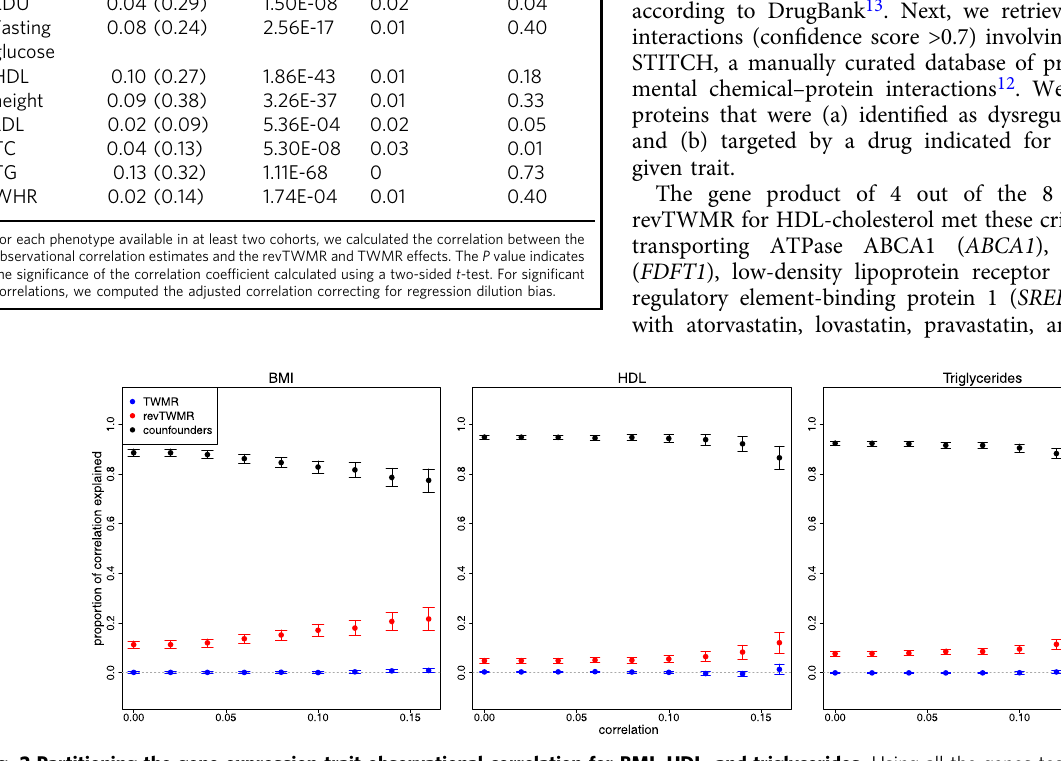
Fig. 2 Partitioning the gene expression-trait observational correlation for BMI, HDL, and triglycerides. Using all the genes tested by TWMR and revTWMR ( N = 10,395 for BMI, N = 10,391 for HDL, and N = 10,390 for TG), for each bin of correlation (absolute value) we plotted the combined contributions of the forward (TWMR, blue dots) and reverse (revTWMR, red dots) effect of the gene expression on the trait, the contribution of confounders (black dots). Data were presented as estimated contributions and 95% con fi dence